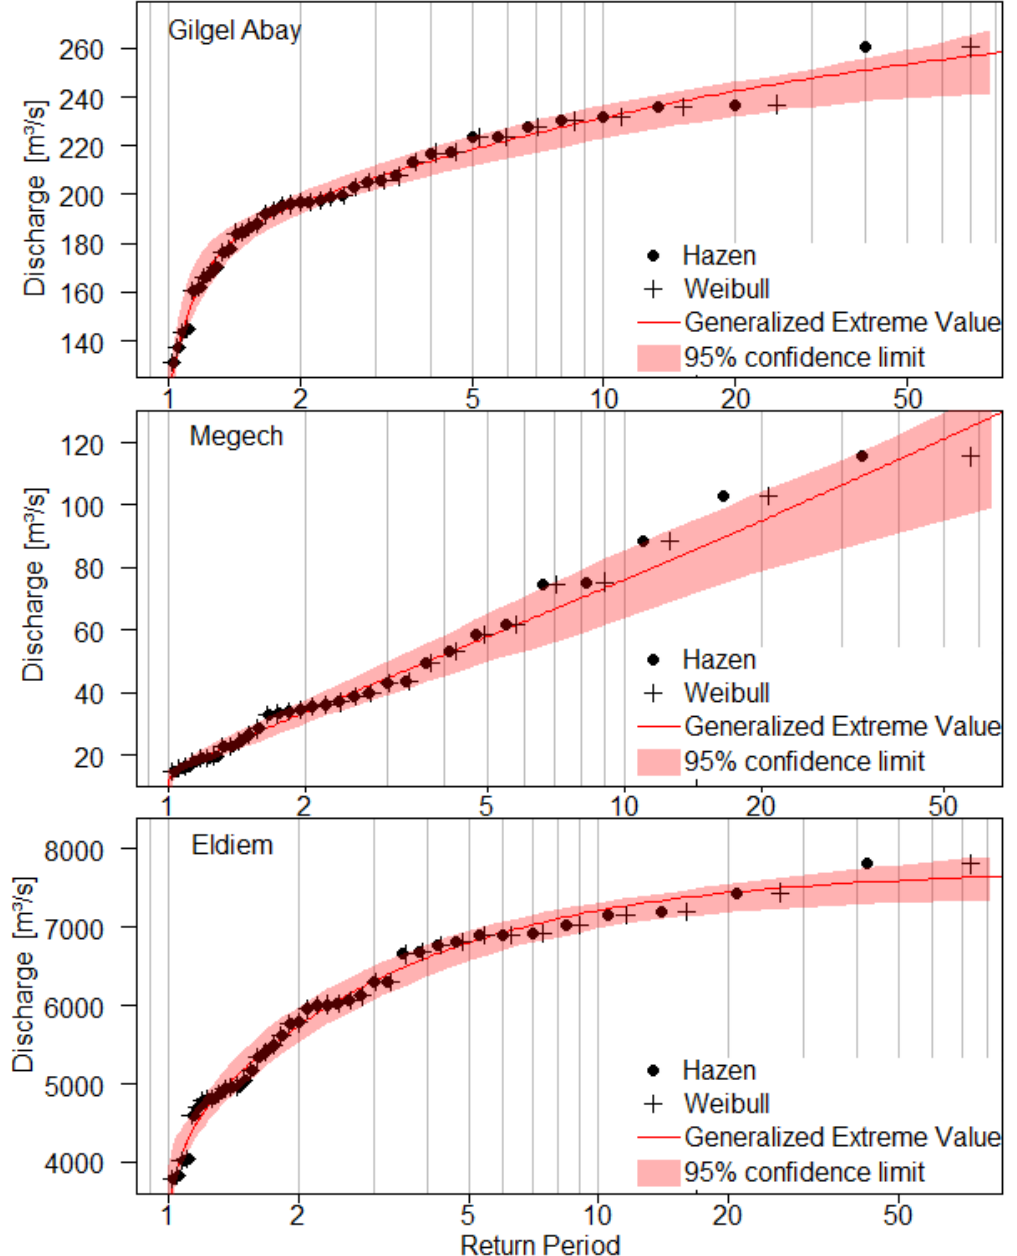
Figure 6. The flood frequency curves with 95% confidence limits for Gilgel Abay (top), Megech (middle), and Eldiem (bottom) gauging stations.